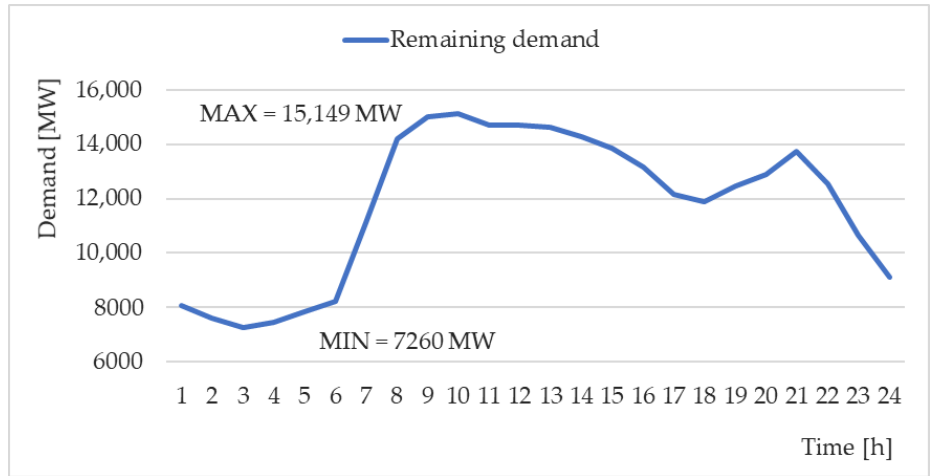
Figure 5. The assumed fixed profile of non-dispatchable generation. Data source [36].